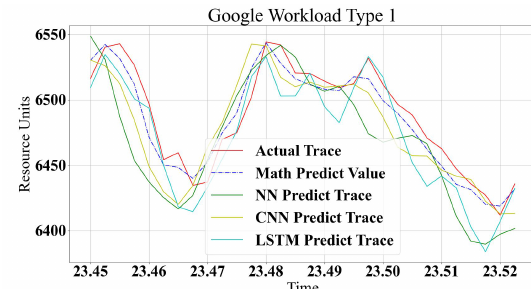
Figure 10. Google Workload Type 1.